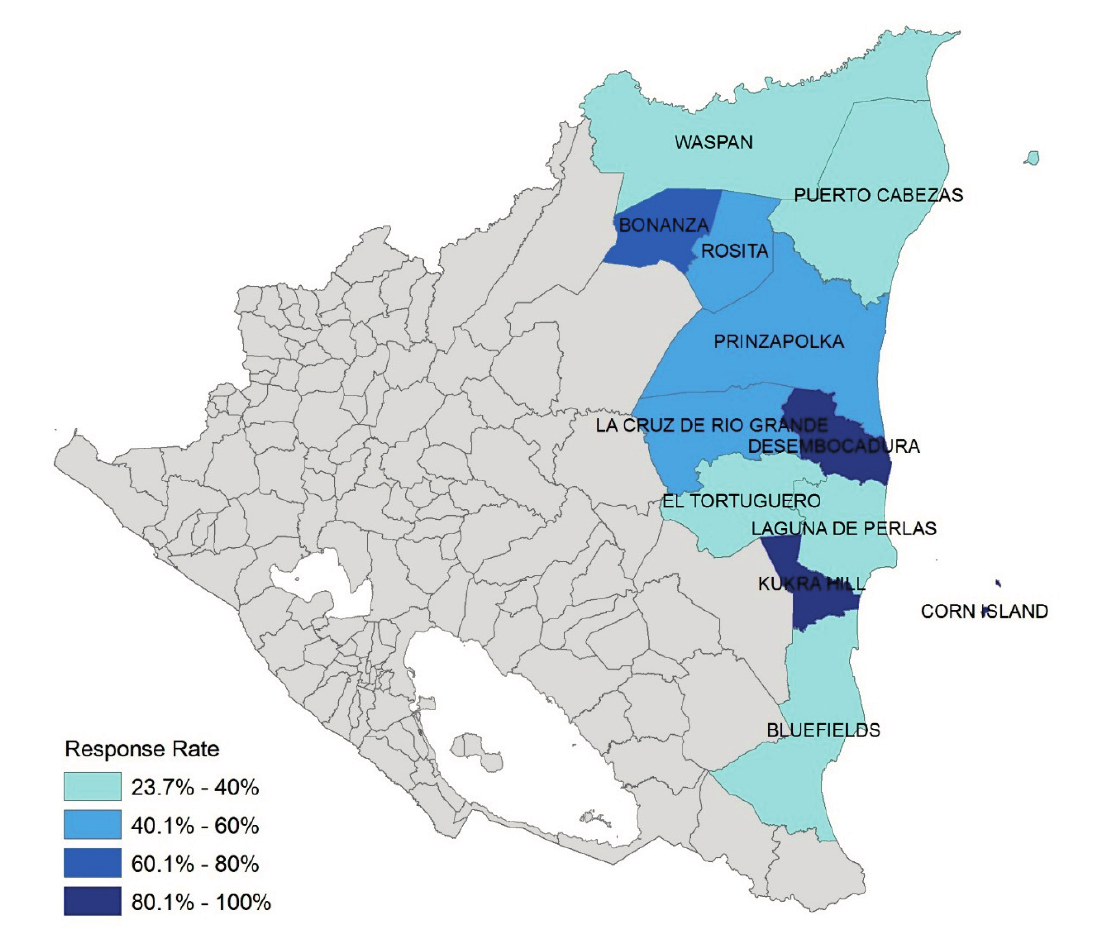
Figure 1. Survey response rate by